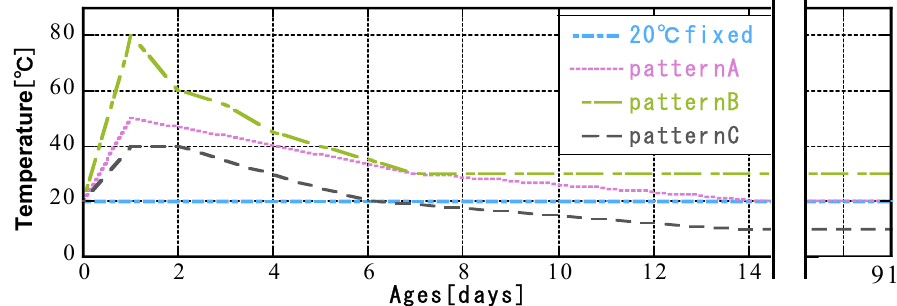
Materials 2023 , 16 , x FOR PEER REVIEW Figure 3. Curing temperature history. Figure 3. Curing temperature history.